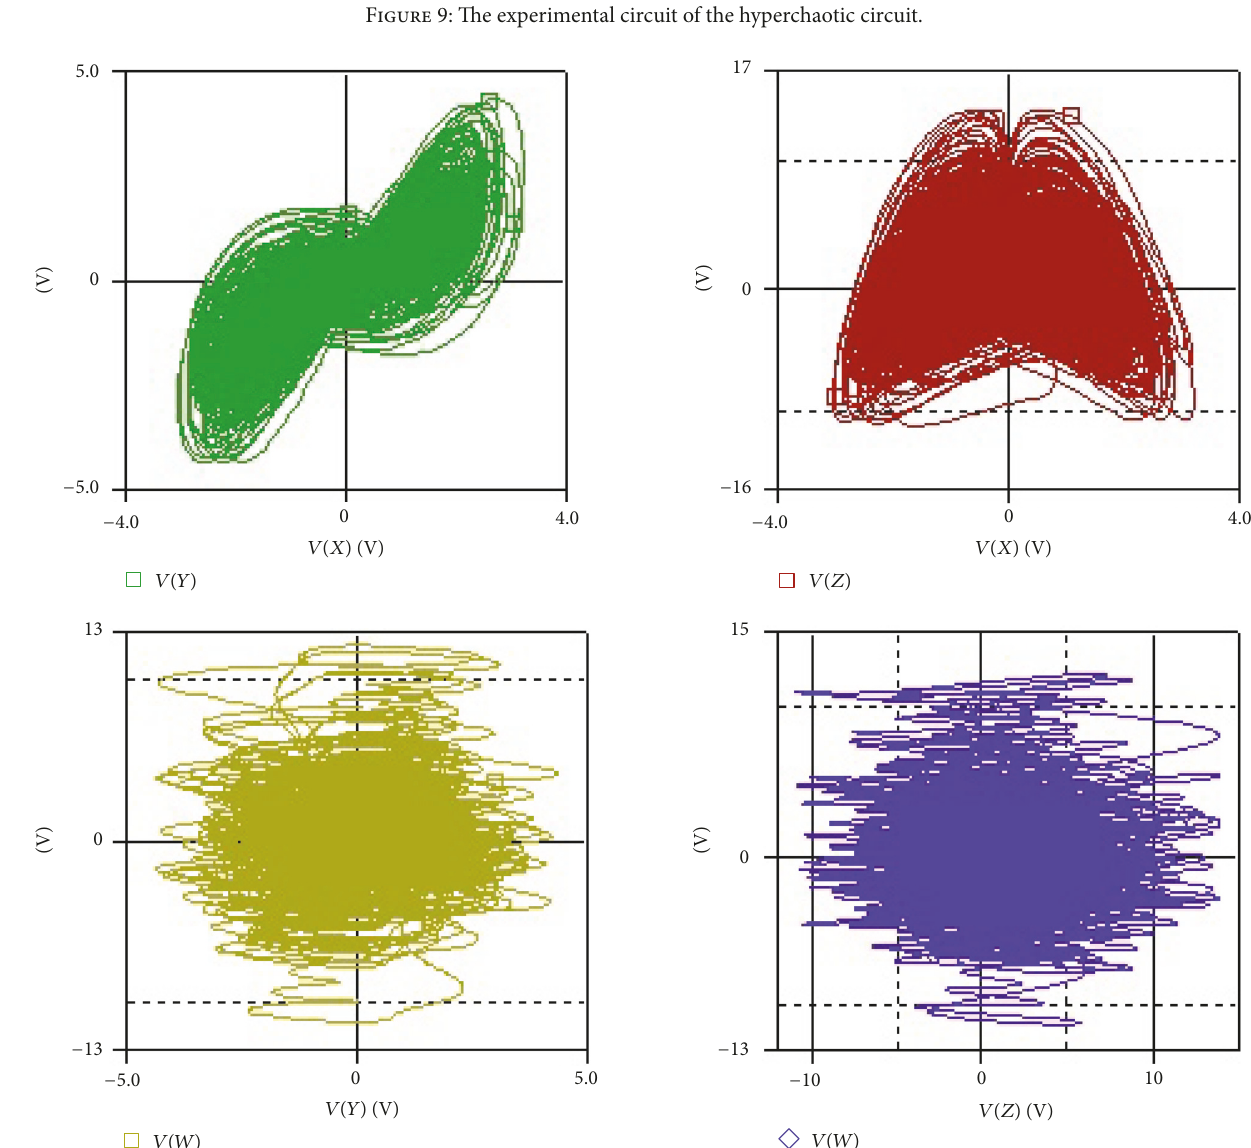
Figure 10: The phase portraits of scaled hyperchaotic system (17) in